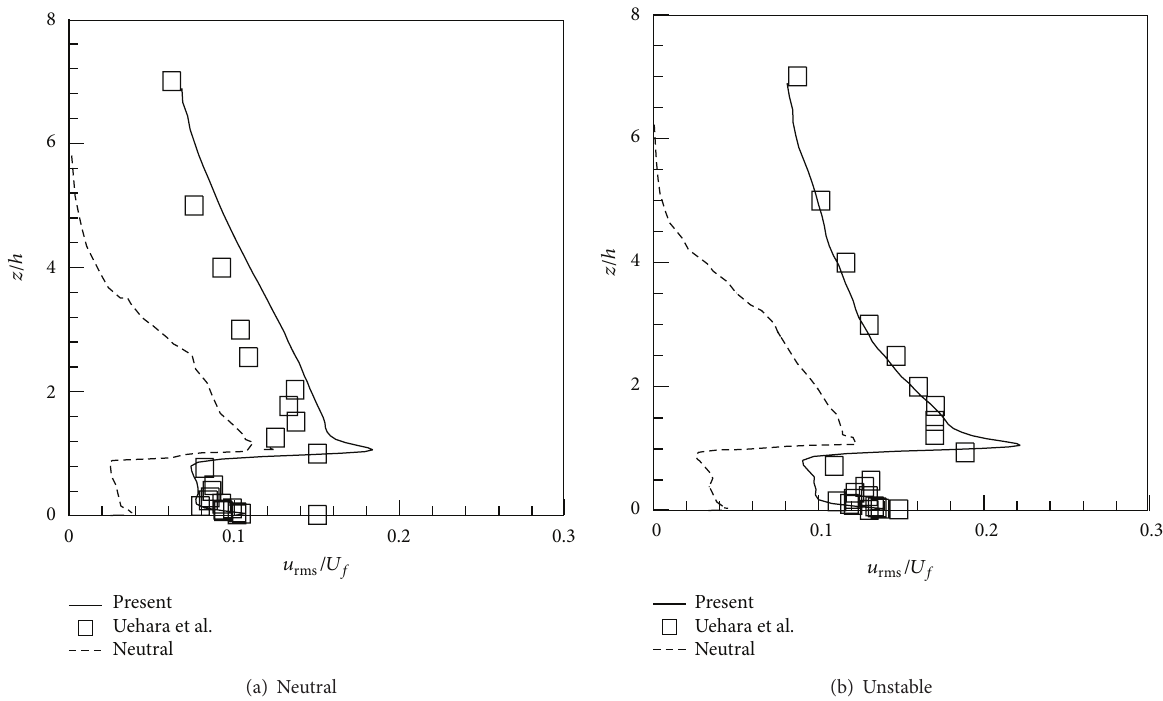
Figure 5: Vertical profiles of streamwise turbulence intensity 𝑢